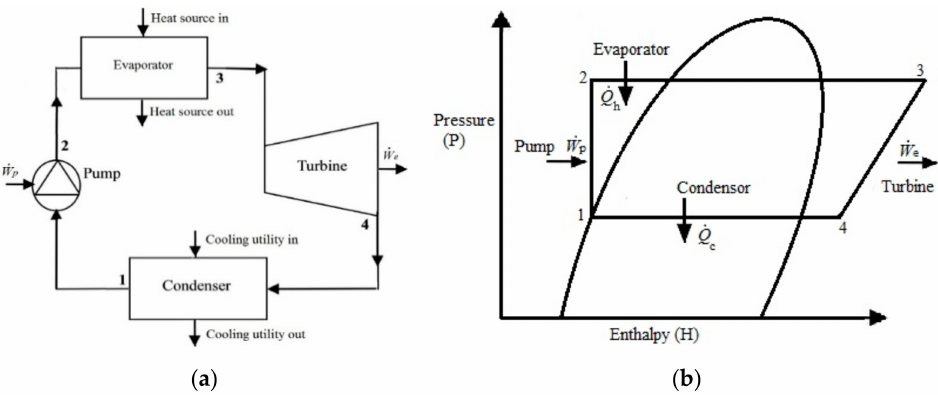
Figure 1. ( a ) Schematic of ORC power-cycle system. ( b ) Pressure–enthalpy diagram for cycle in ( a